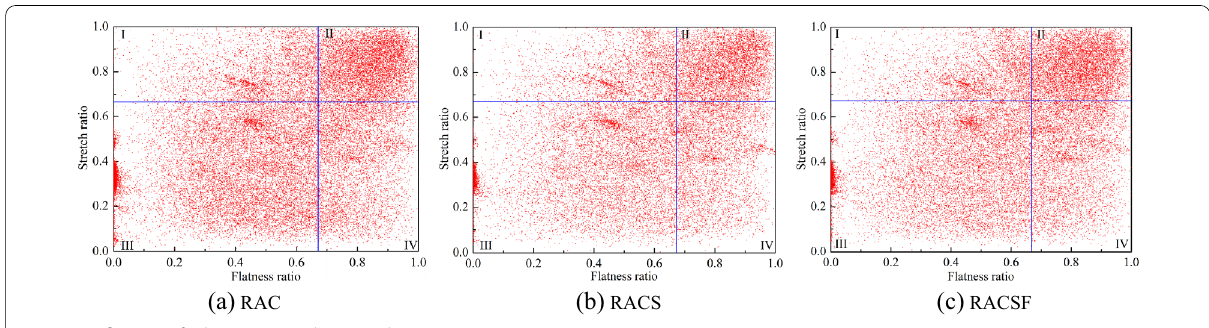
Fig. 14 Influence of admixtures on the pore